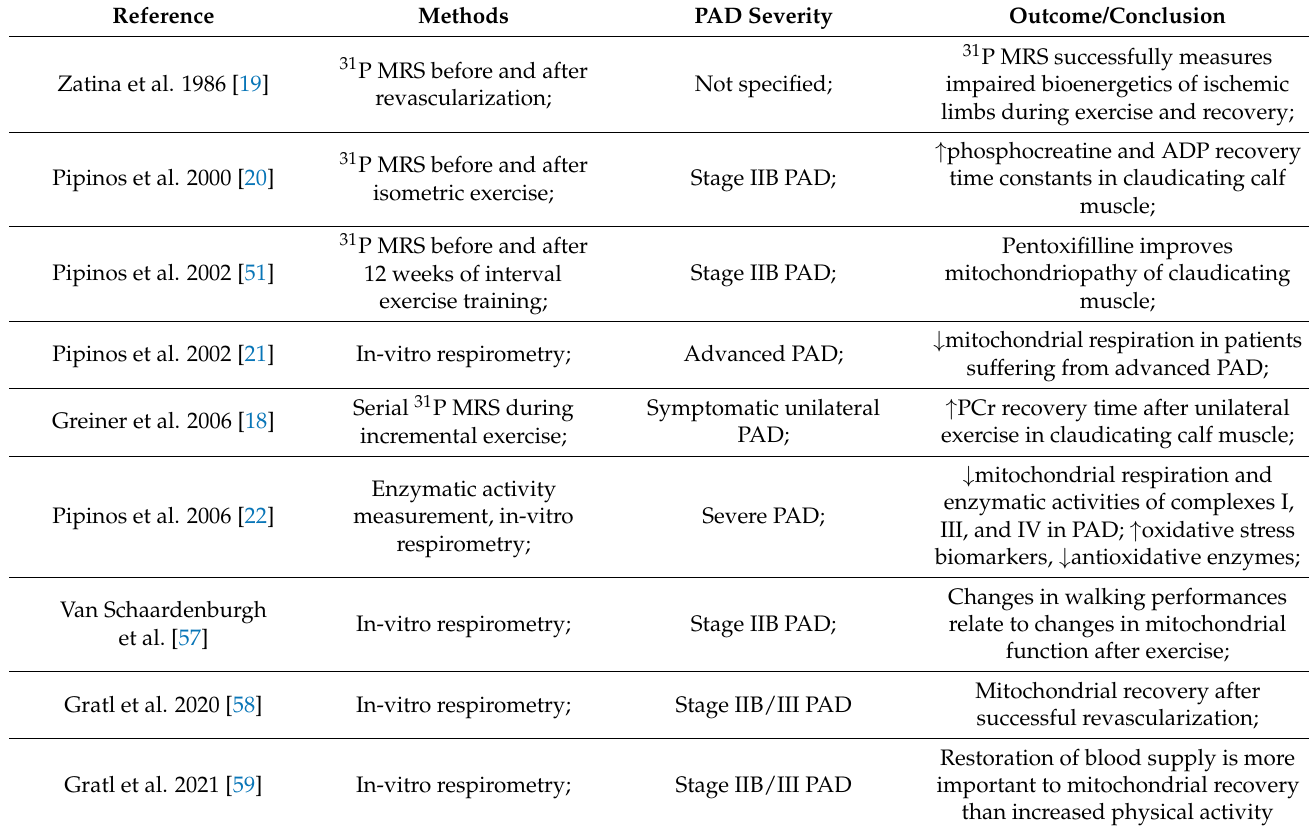
Table 1. Overview of clinical studies investigating mitochondrial function in